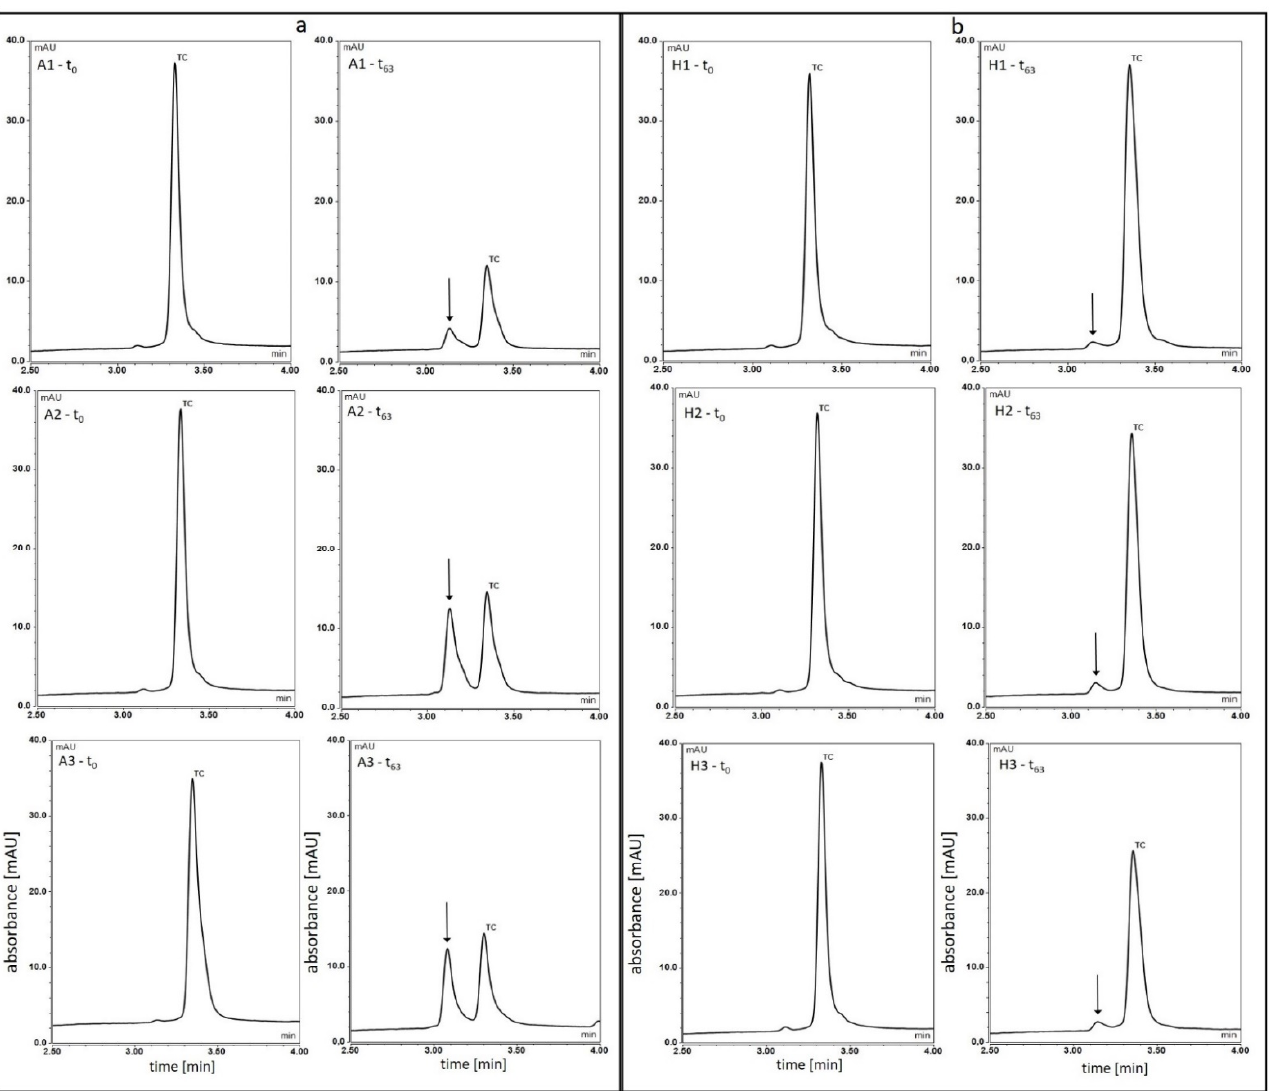
Figure 2. HPLC chromatograms after 0 and 63 days of observation. ( a ) solutions, ( b ) hydrogel samples.